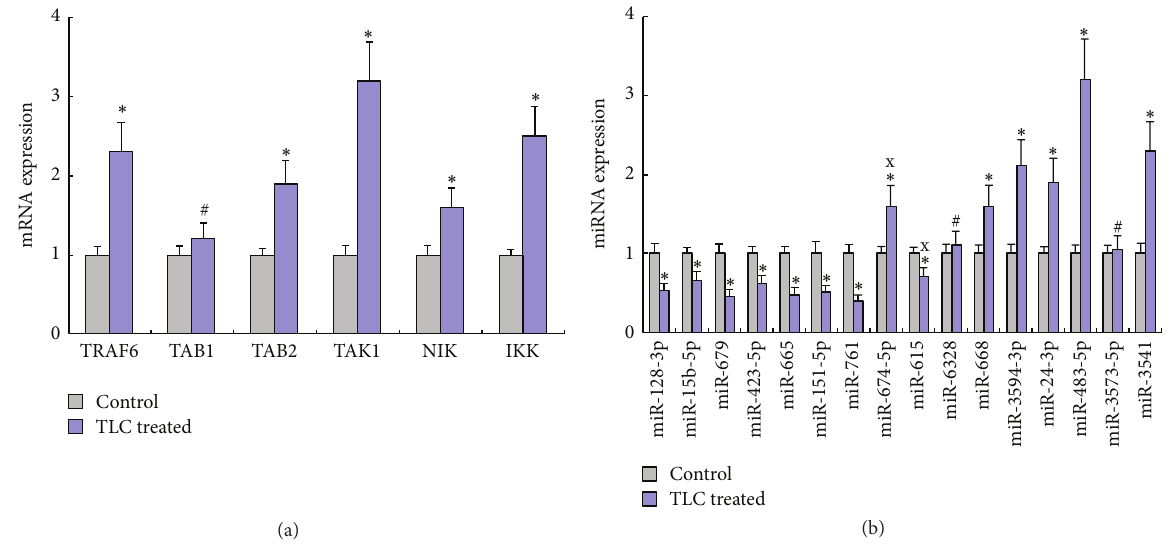
Figure 6: Expression levels of mRNA or miRNA detected by real-time RT-PCR. ∗ Compared to control group, 𝑃 < 0.05 . # Compared to control group, 𝑃 > 0.05 . x The expression level was incompatible between the chip and real-time RT-PCR detection.